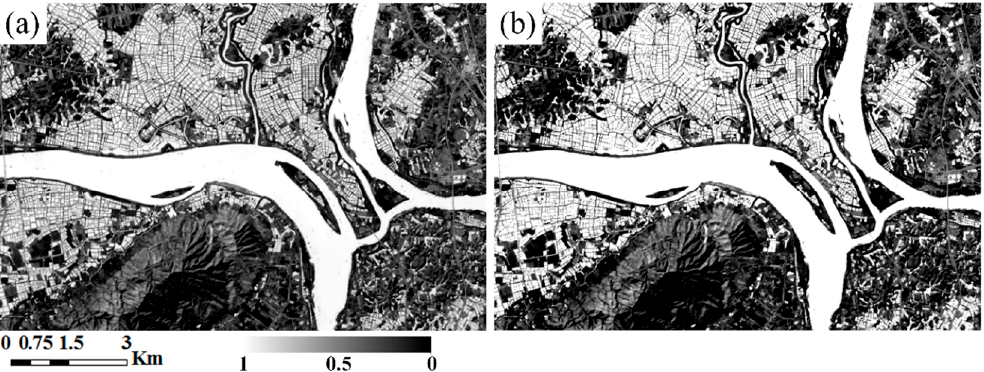
Figure 8. Surface water fractions of Region A extracted by the: ( a ) conventional; and ( b ) modified linear spectral mixture analysis (LSMA) methods.